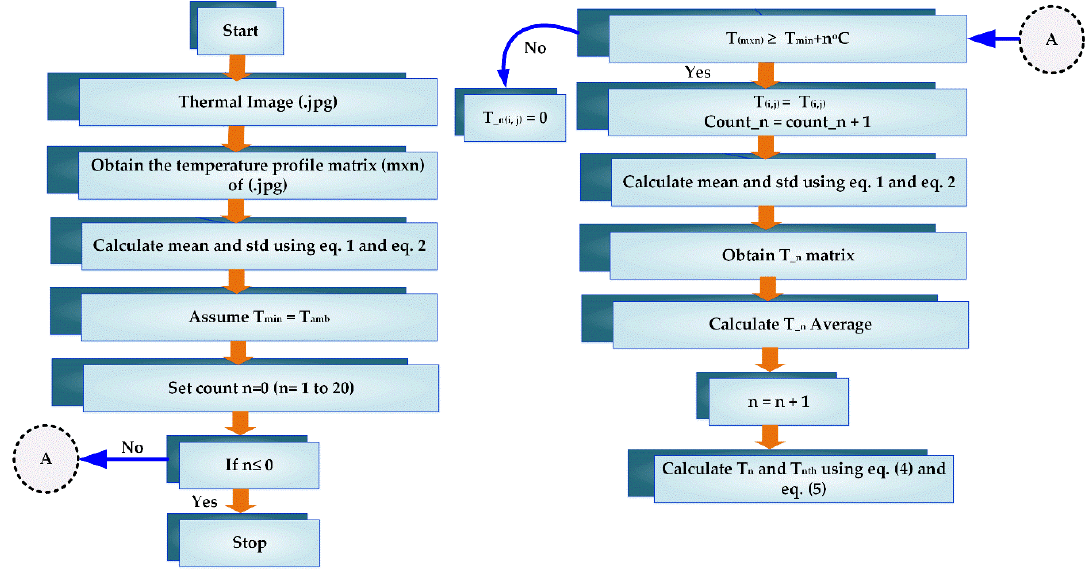
Figure 3. Photograph and thermal image of the Photovoltaic (PV) panel: ( a ) healthy, ( b ) Ethylene Vinyl Acetate (EVA) discolouring defect, ( c ) delamination defect.